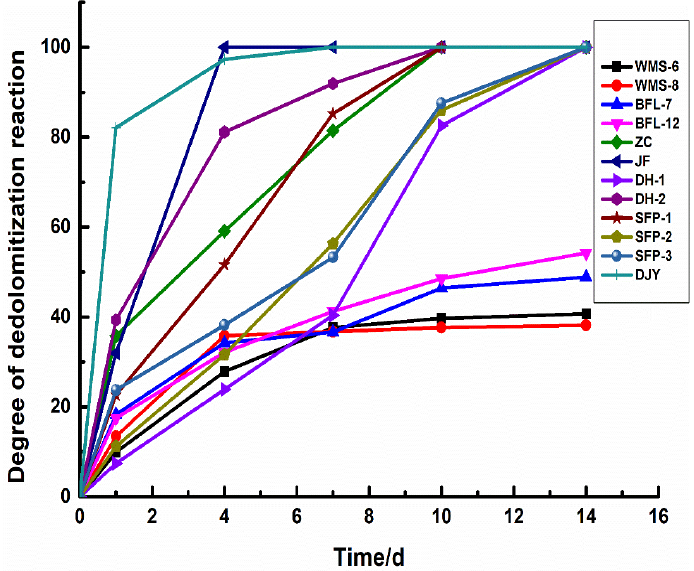
Figure 9. The degree of dedolomitization reaction in rocks.